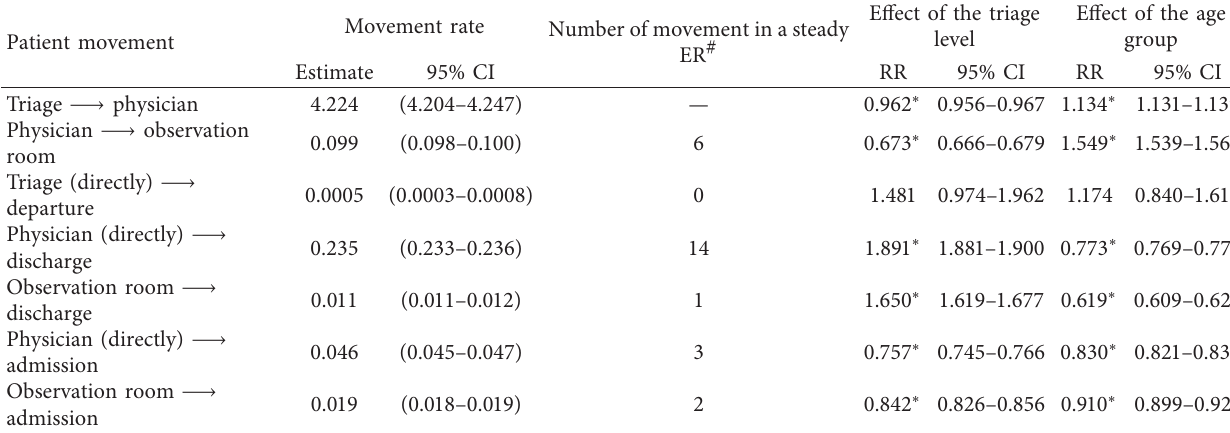
Table 2: Estimated rates of patient movement rates (per person-hour) and the effects of the age group and triage level from the five-state Markov